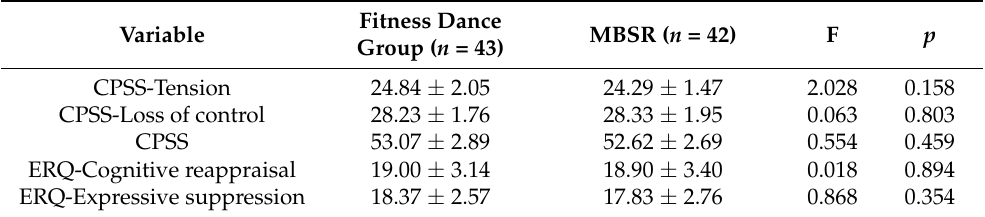
Table 2. Comparison of baseline balance of perceived stress and emotion regulation between two groups of participants (M ± SD).